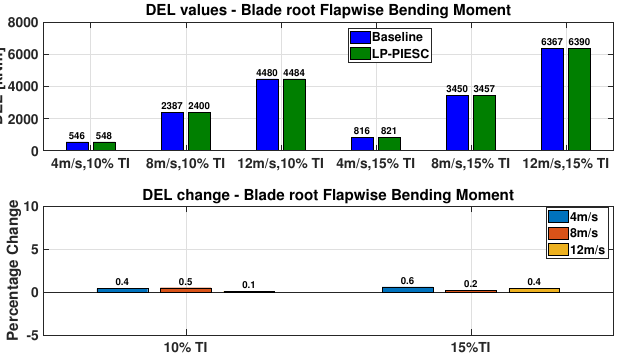
Figure 30. Blade root flap-wise bending moment comparison: Baseline vs. LP-PIESC. Aggregate DEL values with baseline controller and LP-PIESC ( top ), percentage change in DEL ( bottom ) for time series from 300 s to 3000